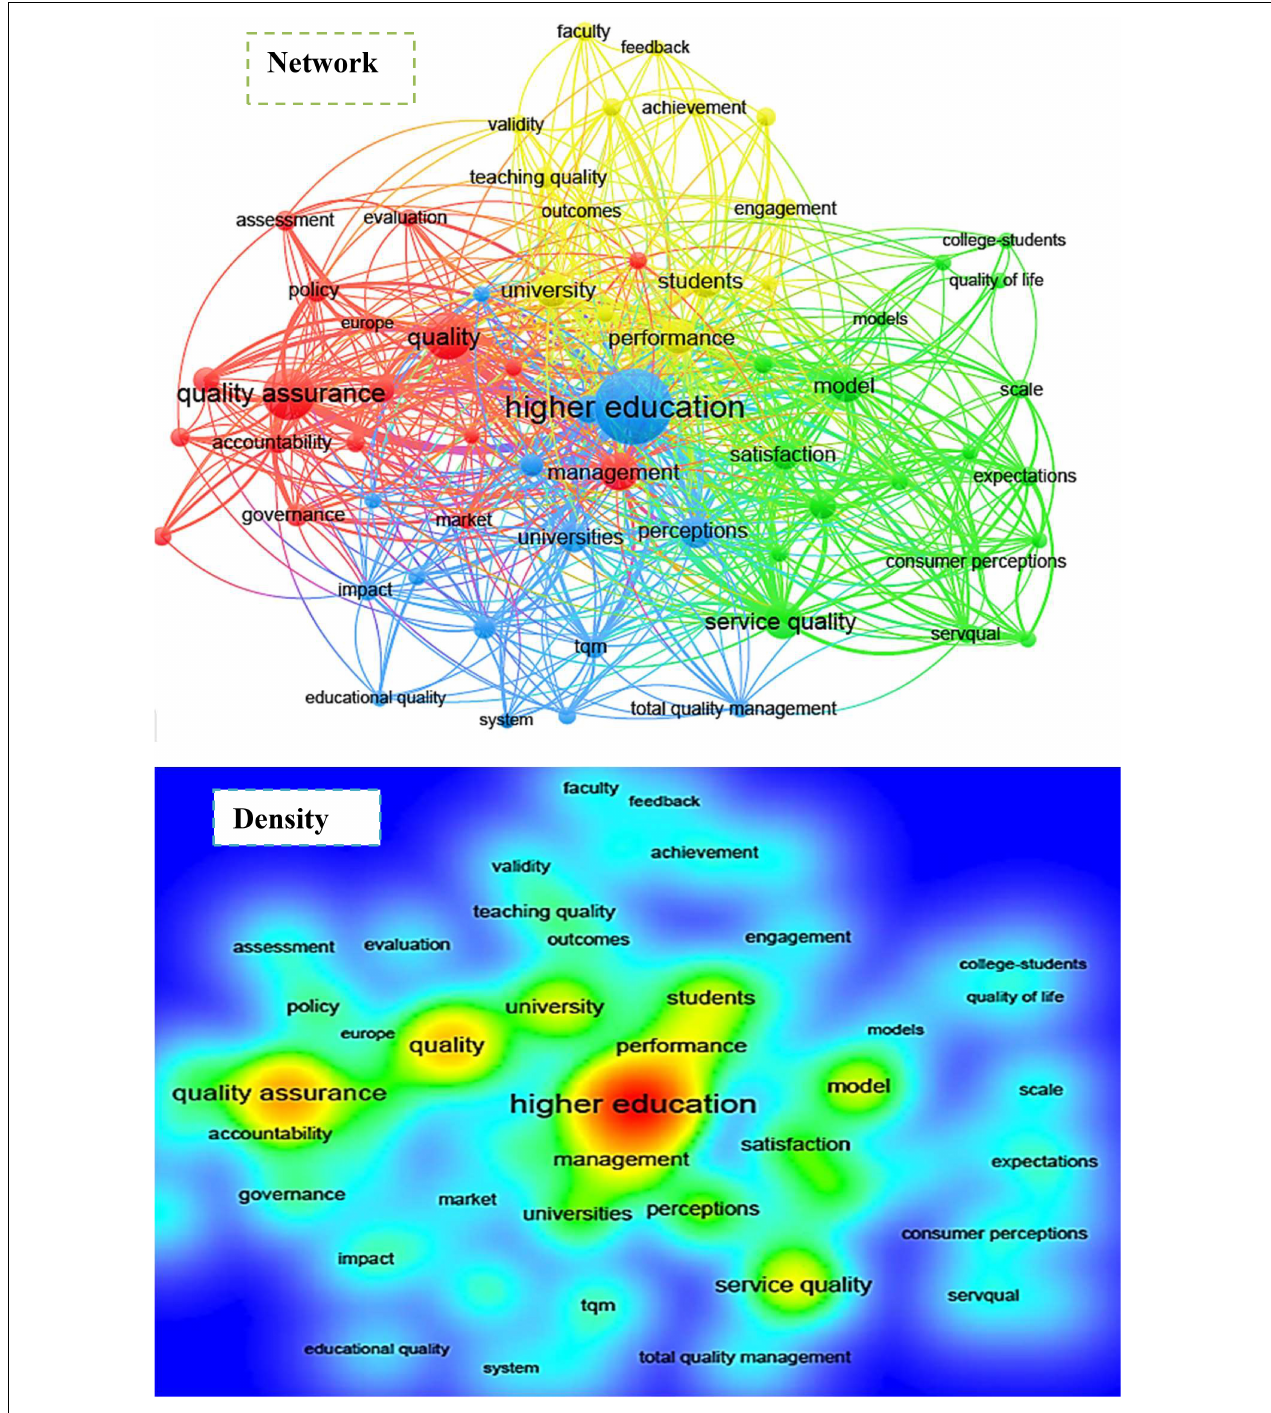
FIGURE 1 | Network and density of the appearance of keywords in the quality of higher education.